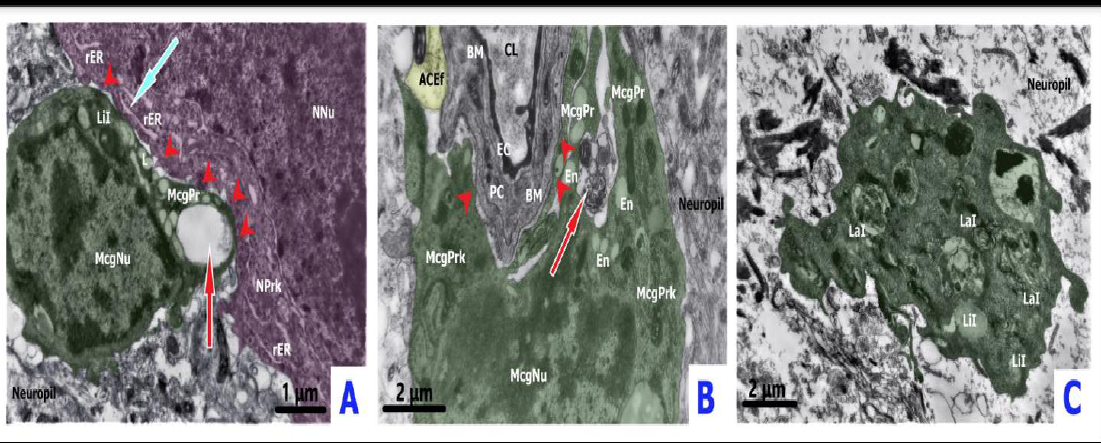
Figure 5. Microglial reactivity and interactions in sepsis-associated encephalopathy. Panel ( A ) depicts a phagocytic amoeboid microgliocyte (pseudo-colored green) contacting neuron (pseudo-colored pink) with ischemic condensation and shrinkage from the cortex of a non-survived CLP-B rat at 30 h after the CLP procedure. The presence of direct point contacts occurring between cellular plasma membranes are represented by red arrowheads. The rough ER within neuronal perikaryon near the microglial–somatic junction is slightly broadened and forms a number of ER-plasmalemmal contacts (blue arrow). Microglial perikaryon contains lysosome-like structures and lipid inclusions; filopodia enveloping a large neuropil droplet for phagocytosis (red arrow). Dilated pockets of extracellular space around microglial cell body are noted. Panel ( B ) depicts electron-dense endothelial cell (EC) shrinkage and focal thickening of the capillary basement membrane (BM). Direct dotted attachment (red arrowheads) of the hypertrophic-like juxtavascular microgliocyte (pseudo-colored green) to the naked and thickened basement membrane devoid of pericytes and astrocytic endfeet. Increased number of diverse endosomes in the cytoplasm of perikaryon and processes; partial homogenization and dispersion of the nuclear heterochromatin are present. Enlarged pockets of extracellular space were filled by small conglomerates of tissue debris (red arrow) intended for phagocytosis via encircling microglial processes. This image is from the cortex of a survived CLP-A rat 48 h after the CLP procedure. Panel ( C ): Gitter cell-like (green) microgliocyte located within the destroyed, edematous neuropil without preserved tissue compartments. The irregular shape of the body did not display the presence of a nucleus; cytoplasm was filled with complex lamellar inclusions, lipofuscin-like lipid inclusions, and residual bodies. This image was taken at the border zone between the cortex and white matter of a non-survived rat (CLP-B group) 38 h after the CLP procedure. Note that control model cortical surveilling microgliocyte was previously described in detail and demonstrated in Figure 3A. ACEf—astroglial capillary